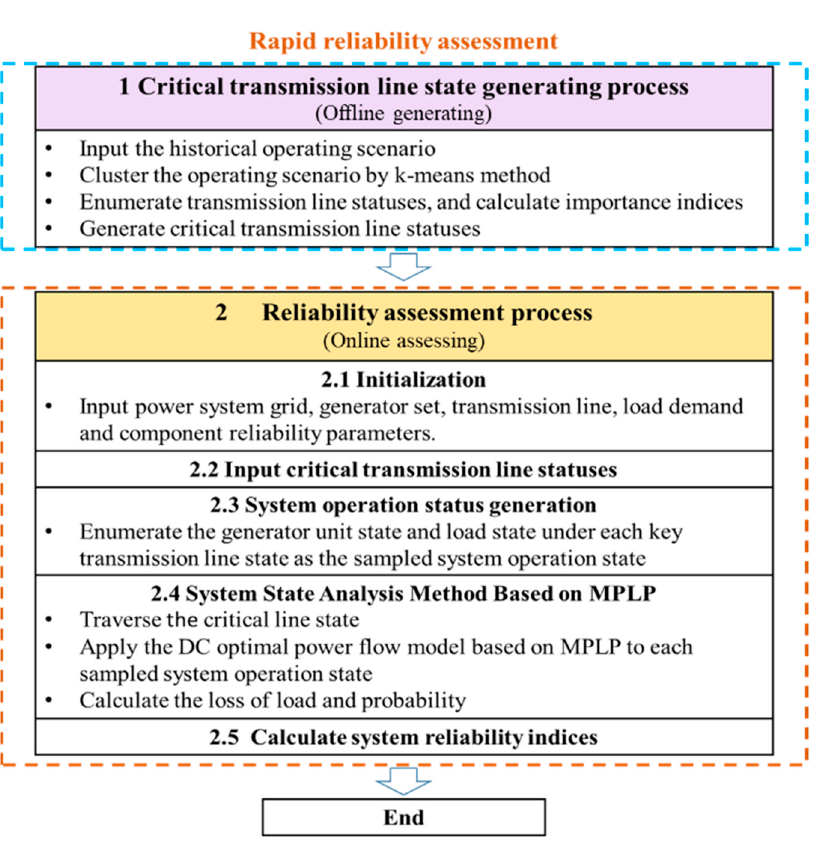
Figure 2. Flow chart of rapid reliability assessment.